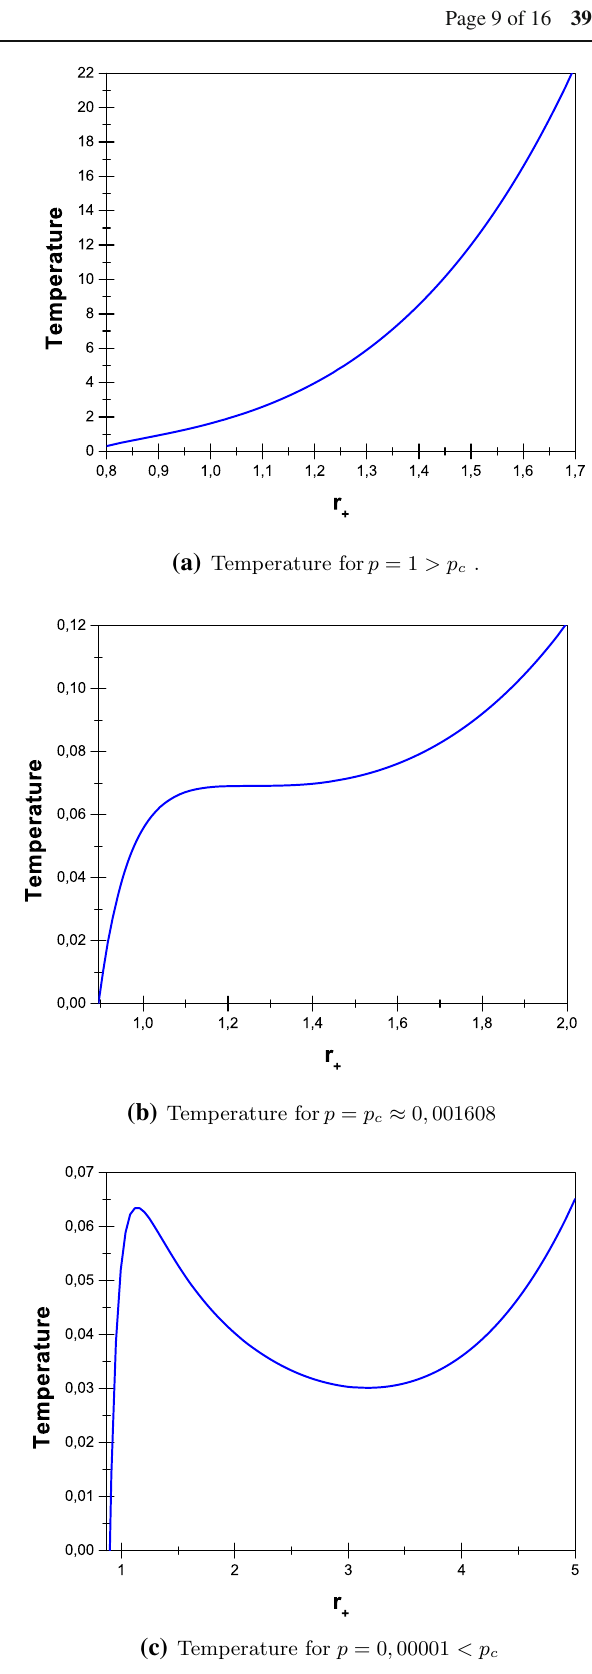
Fig. 3 Temperature behavior for n = 3 and d = 10 with Q =